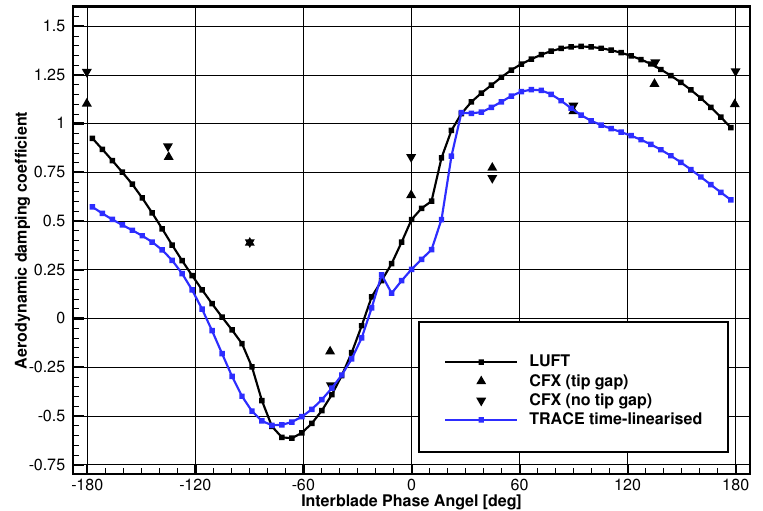
Figure 6. Aerodynamic work coefficient predicted by linearTRACE in comparison with results published by Sun et al.